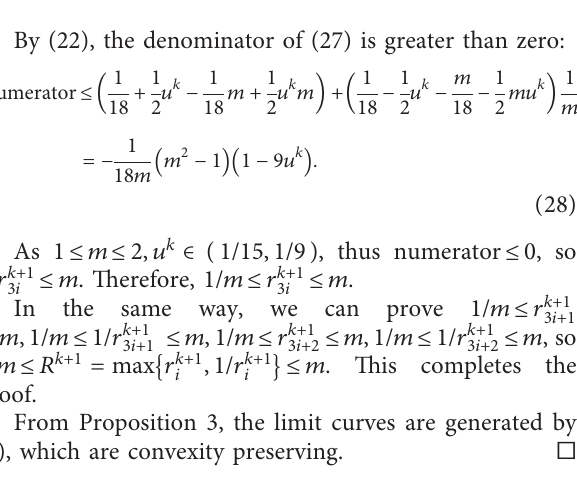
u � 1/12. The initial polygon derives from f ( x ) � sinh ( x ) . k ⟶∞ k